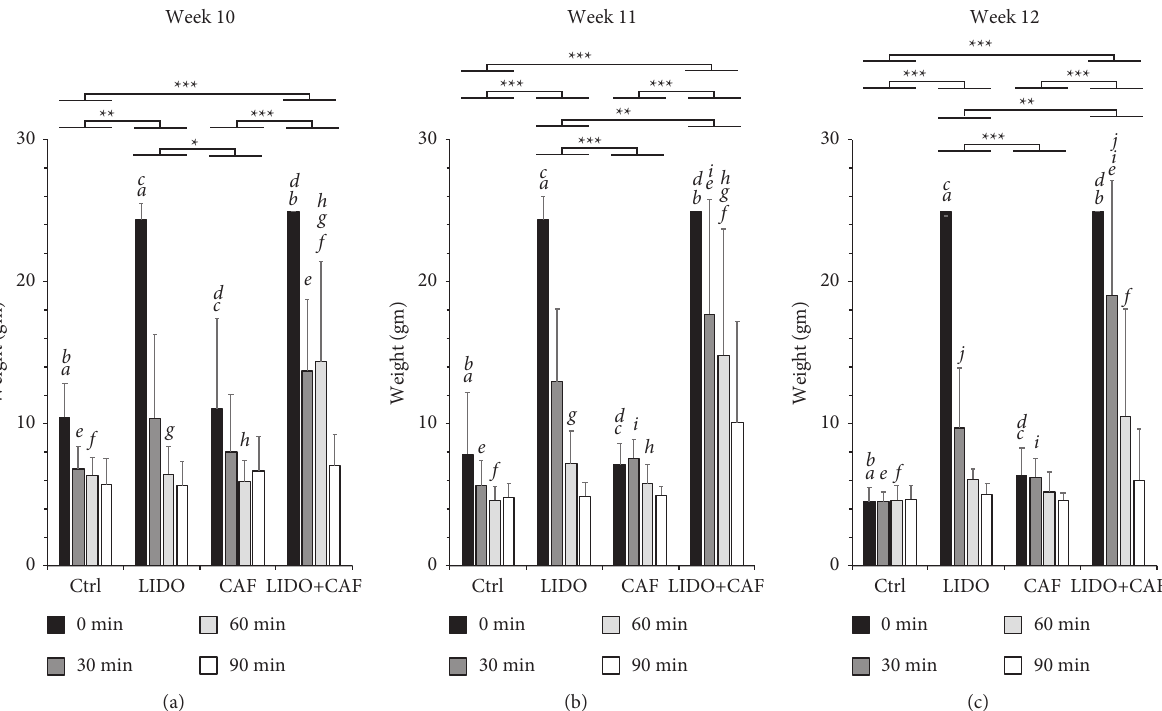
Figure 2: Effects on the mechanical pressure sensation test. The bar graph shows the weights (gm) applied to the rat limb until retraction and were tested 0, 30, 60, and 90 minutes after the local (intraplantar) administration of lidocaine. The rats were divided into 4 subgroups ( n � 8) as follows: control (Ctrl), receiving a local lidocaine injection (LIDO), habitual caffeine intake (CAF), and habitual caffeine intake and receiving a local lidocaine injection (CAF+LIDO). Caffeine was provided in the drinking water to the respective groups for 10-week (a), 11- week (b), and 12-week (c) periods. The statistical analysis was performed using a linear mixed model with repeated measures, and the main effects and time-specific differences were compared with adjustment using the Bonferroni test. Significant differences between the ex- perimental groups are shown with the connecting bars and asterisks ( ∗ < 0 . 05 , ∗∗ < 0 . 01 , ∗∗∗ < 0 . 0001 ) . Significant differences between the groups for the individual time points are indicated with small letters, where every two similar letters indicate a statistically significant difference ( p < 0 . 05 ) between the two groups they represent for the specific time